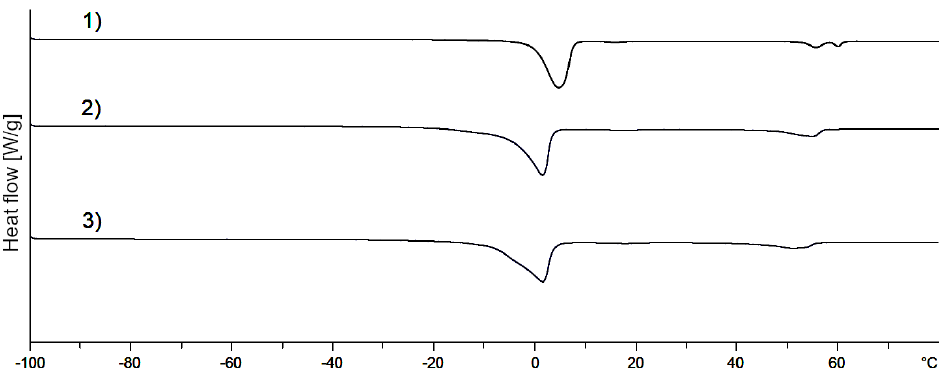
Figure 8. DSC thermograms of (1) mixed crystal without alkanediols; (2) mixed crystal: 2-methyl-2,4-pentanediol, standard concentration; (3) mixed crystal: 1,2-pentanediol, standard concentration.